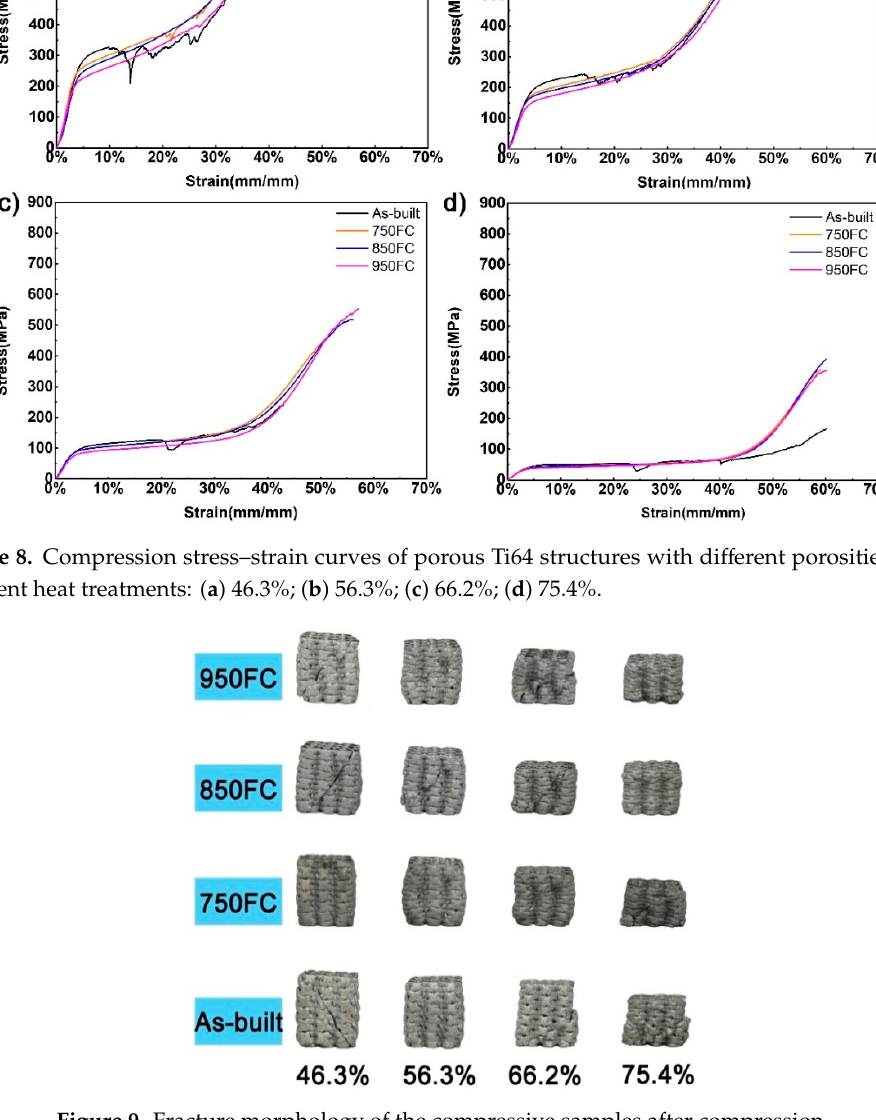
Figure 9. Fracture morphology of the compressive samples after compression.